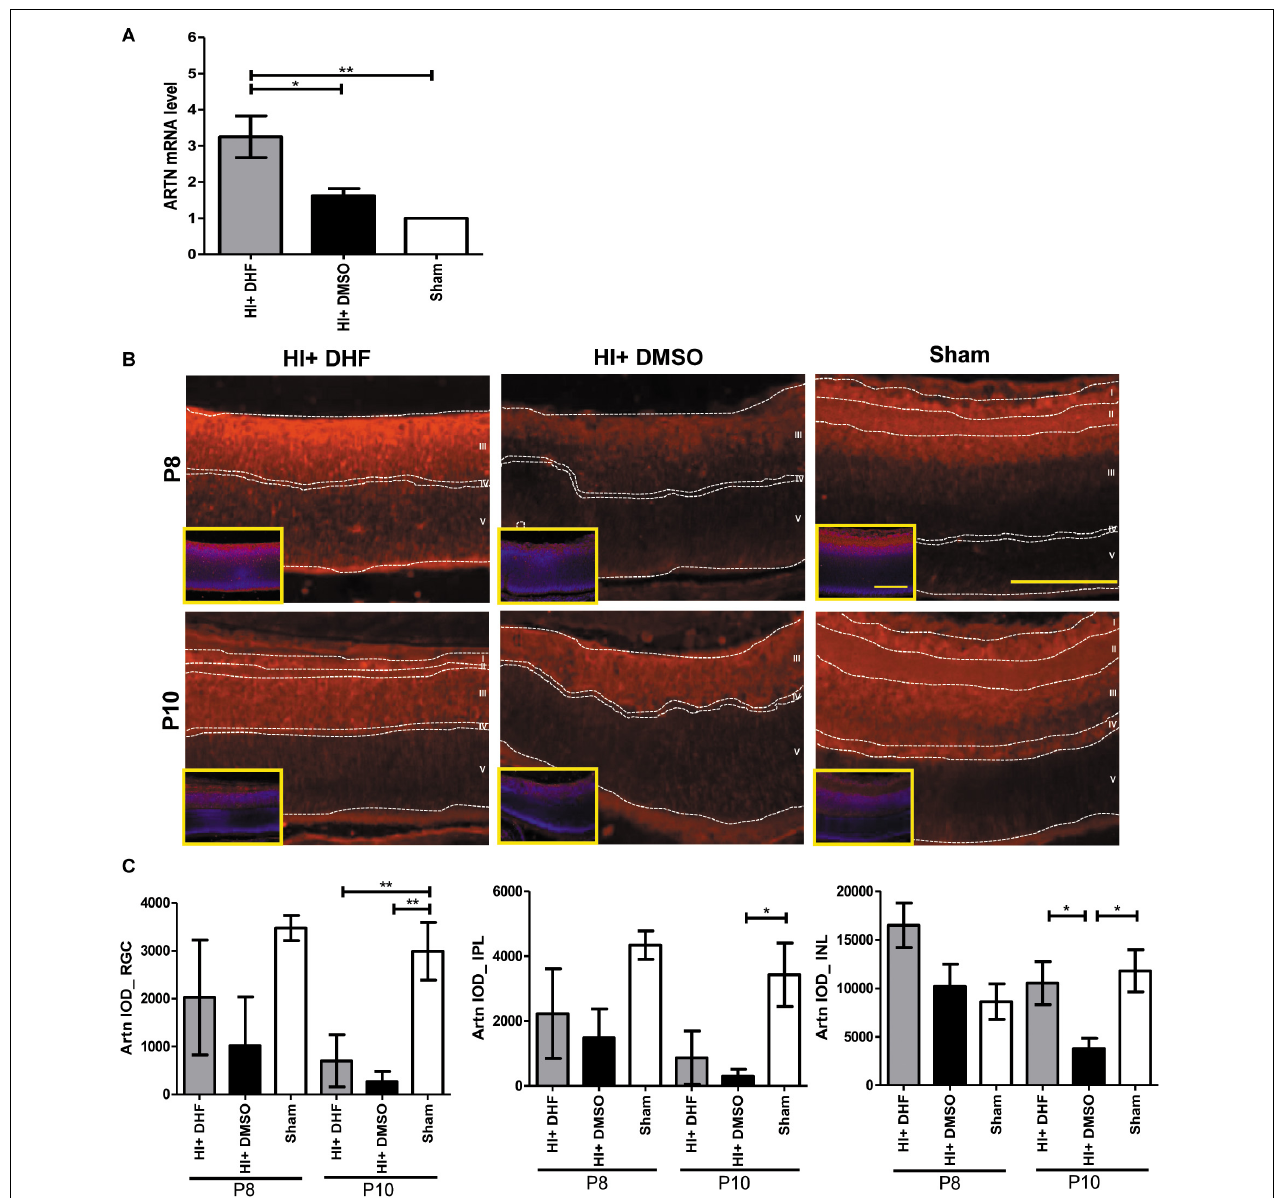
FIGURE 1 | Systemic TrkB agonist- DHF increases ARTN expression in the HI Injured immature retina. (A) At P8, the ARTN mRNA level significantly increased in the DHF-treated HI group as compared with the DMSO-treated HI and sham control groups. (B) The immunohistochemical stain showed that ARTN protein was expressed in the retina ganglia cells (RGC, layer I), inner plexiform layer (IPL, layer II) and the upper part of inner nuclear layer (INL, layer III) of the sham controls at P8. The ARTN protein expression further extended to outer plexiform layer (OPL, layer IV) in sham controls at P10. There was almost complete loss of layers I and II but preserved layers IV and V (outer nuclear layer, ONL) in both HI groups at P8. The DMSO-treated HI group had decreased ARTN immunostaining in layer III at P8 and P10. In contrast, the DHF-treated HI group had relatively preserved ARTN protein expression in the whole layer III at P8 and P10. The insets showed the nuclear counterstaining with DAPI (blue). (C) The group data showed that there was significant difference in the ARTN immunoreactivity of the RGC layer between the sham controls and both the HI group at P10. The DHF-treated HI group had significantly increased ARTN protein expression in the INL than the DMSO-treated HI group at P10. There was no significant difference of ARTN immunoreactivity in the INL between the sham controls and the DHF-treated HI group. Scale bars = 100 µ m in figures and insets; n = 4 to 10 per group in each time point, power = 0.8, * p < 0.05, ** p <